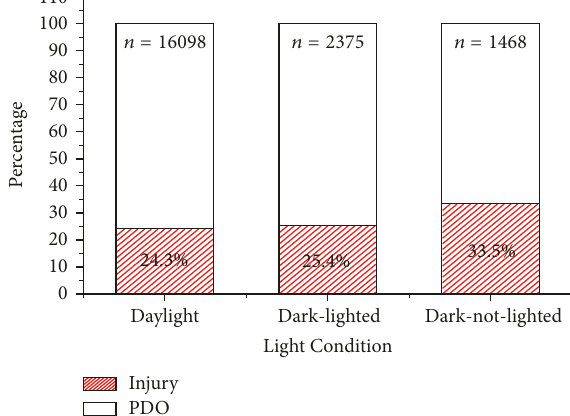
Figure 1: Crash severity distribution under different light condi-